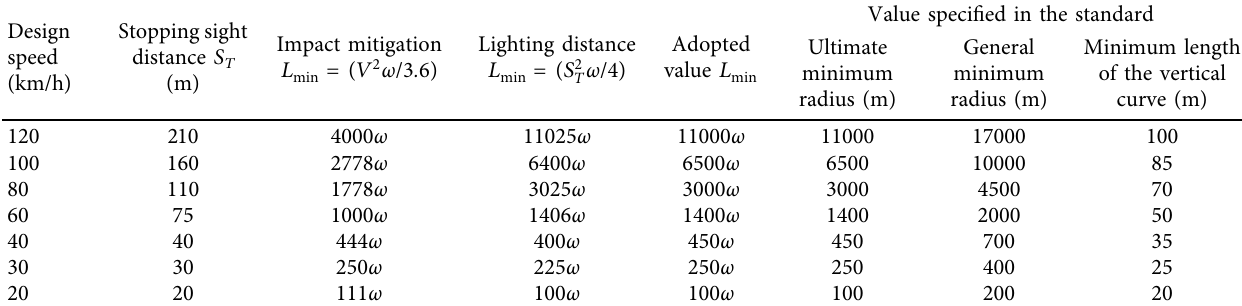
Table 12: The minimum radius and length of a convex vertical curve of an ordinary highway.